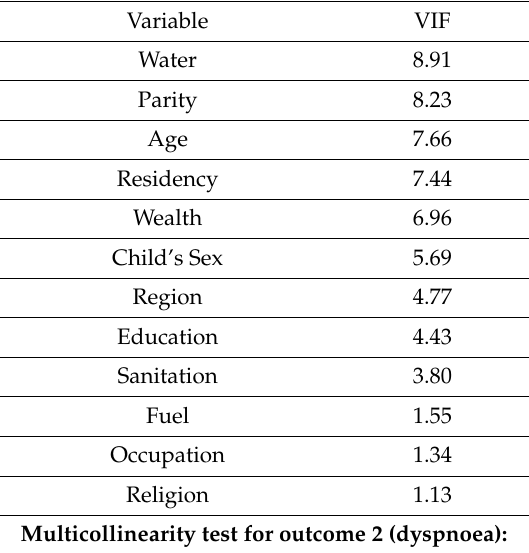
Table A2. Multicollinearity